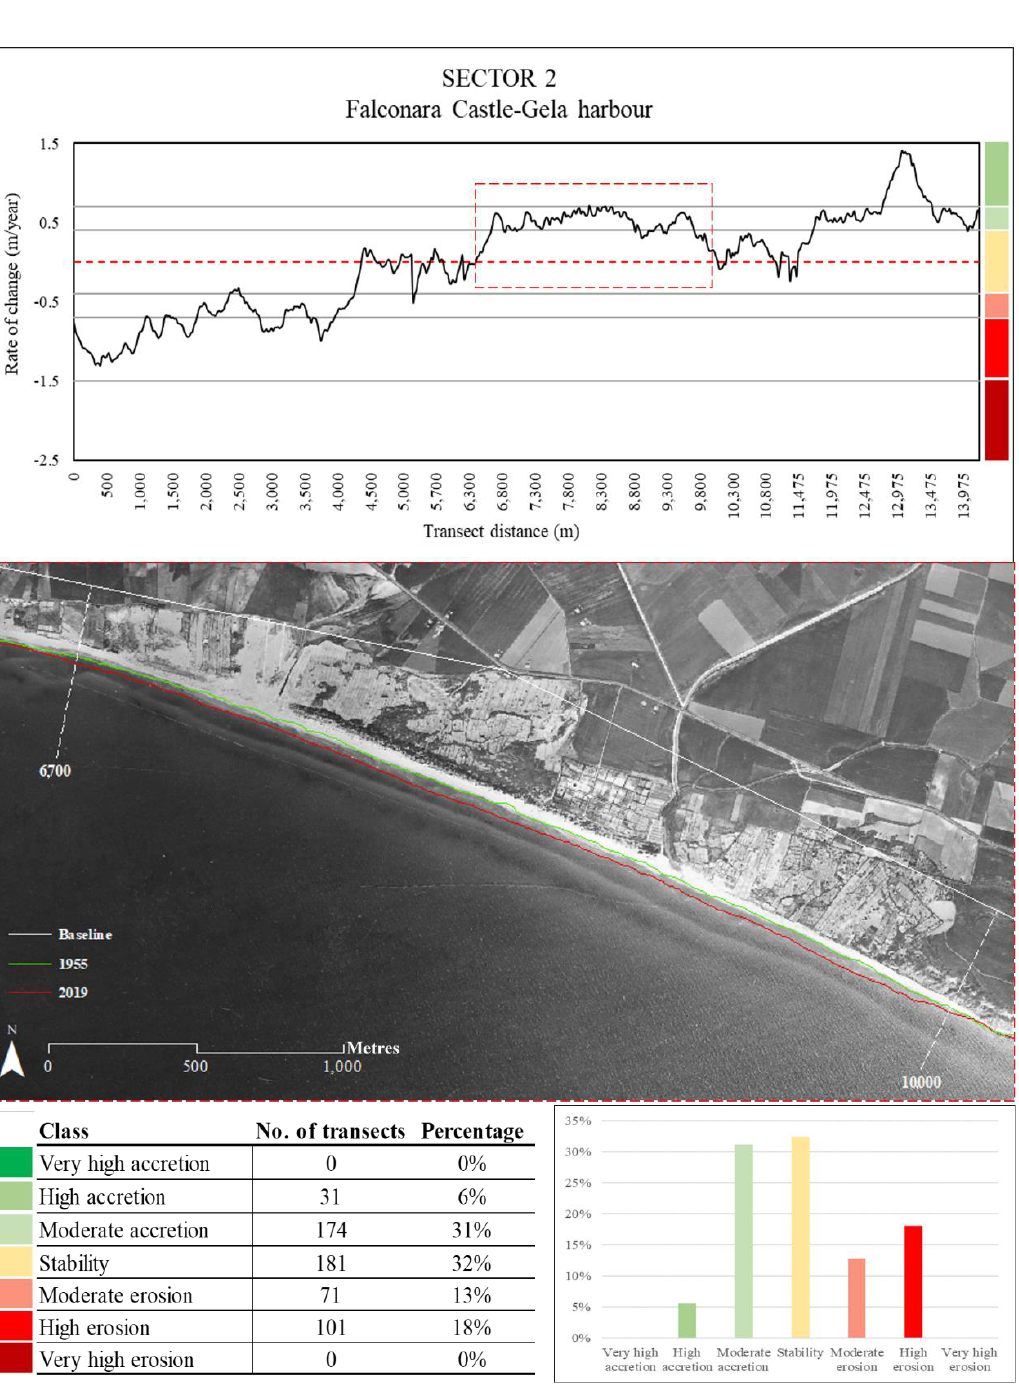
Figure 5. Shoreline evolution expressed as weighted linear regression rate within sector no. 2 over the long-term period (1955–2019). Stable trend (32%, 181 transects) was mainly recorded within sector no. 2, followed by moderate accretion (31%, 174 transects). Significant retreat occurred along 31% (172 transects) of the sector.